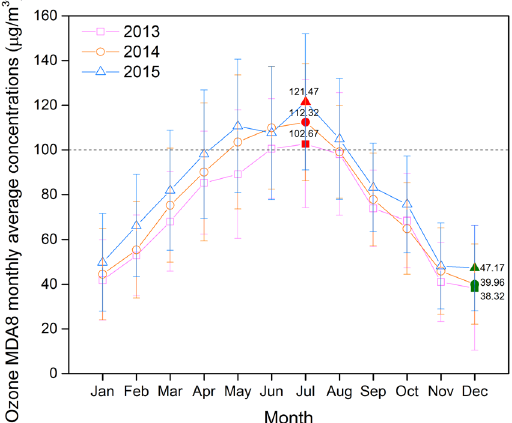
Figure 8. Monthly distribution of the maximum daily eight-hour average (MDA8) concentrations of ground- level ozone in sparsely populated region during